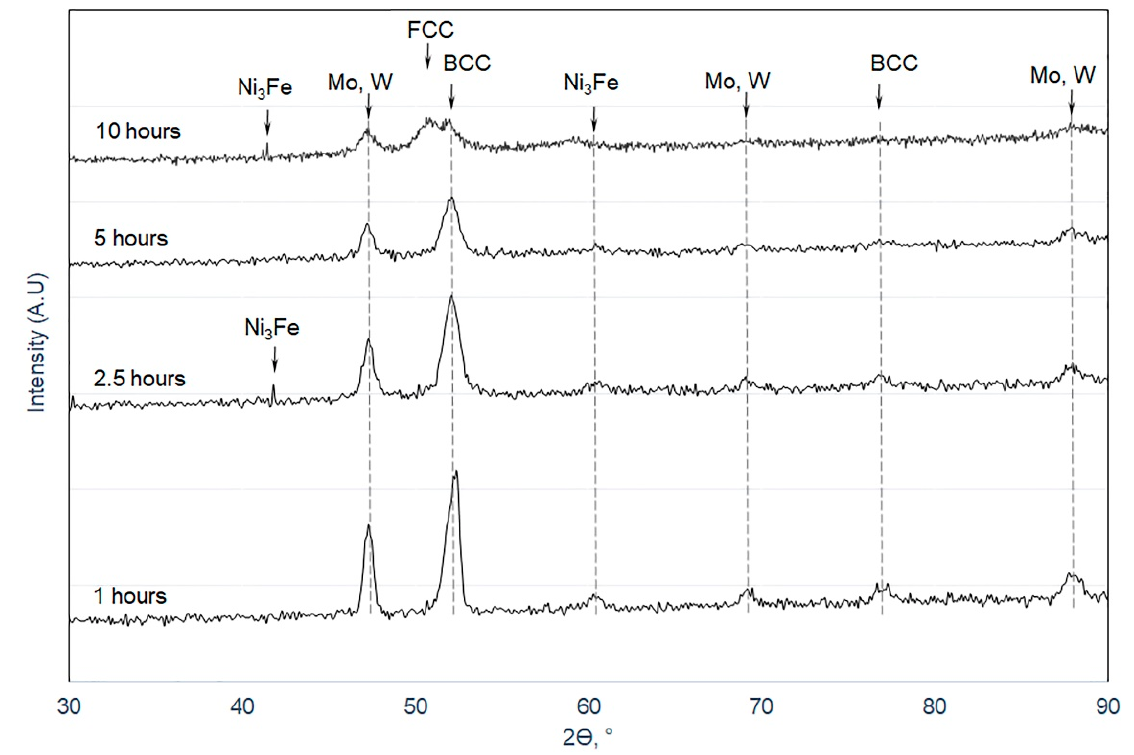
Figure 6. XRD patterns of the 35Fe30Cr20Ni10Mo5W powder produced by mechanical alloying.